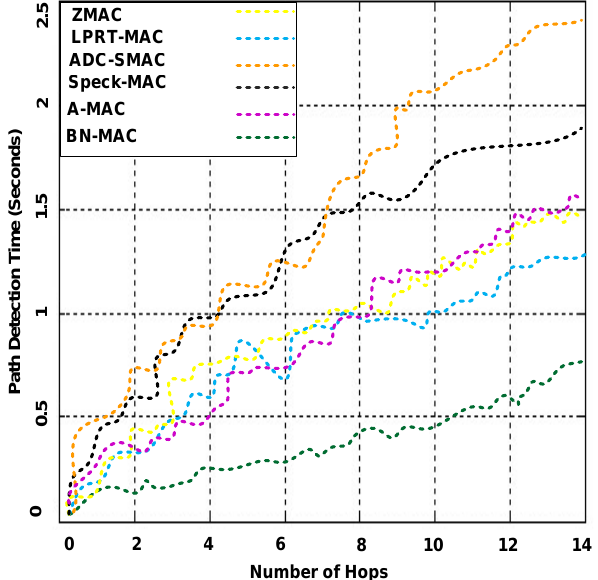
Figure 24. Path detection time for different number of